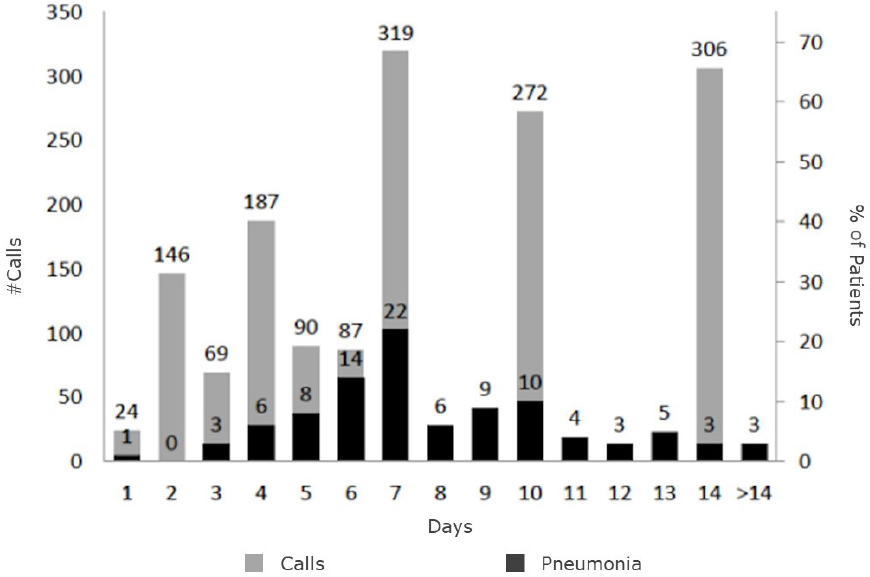
Figure 3. Calls performed and development of SARS-CoV-2 pneumonia in individuals with non- severe disease.